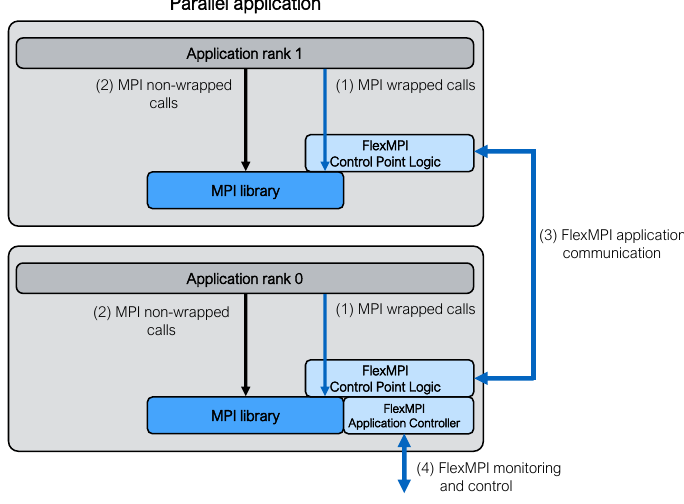
Figure 4. Example of an MPI application executed with the FlexMPI